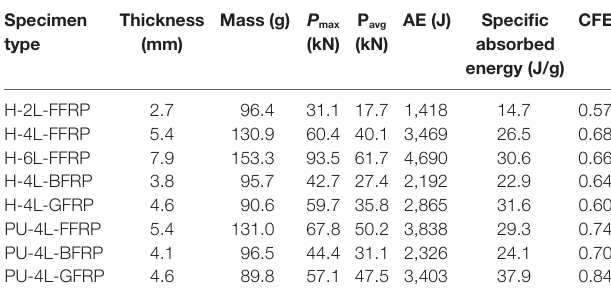
TaBle 2 | Average results of different composite tubes in quasi-static axial compression.